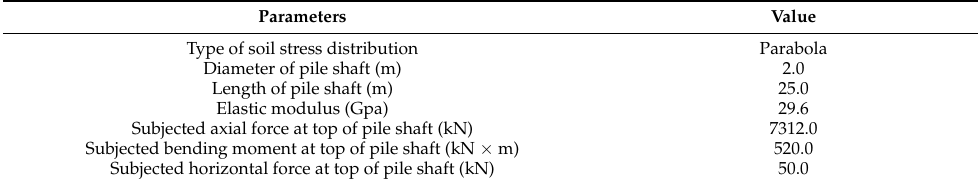
Table 1. Detailed parameters in work of Peng et al. [34].